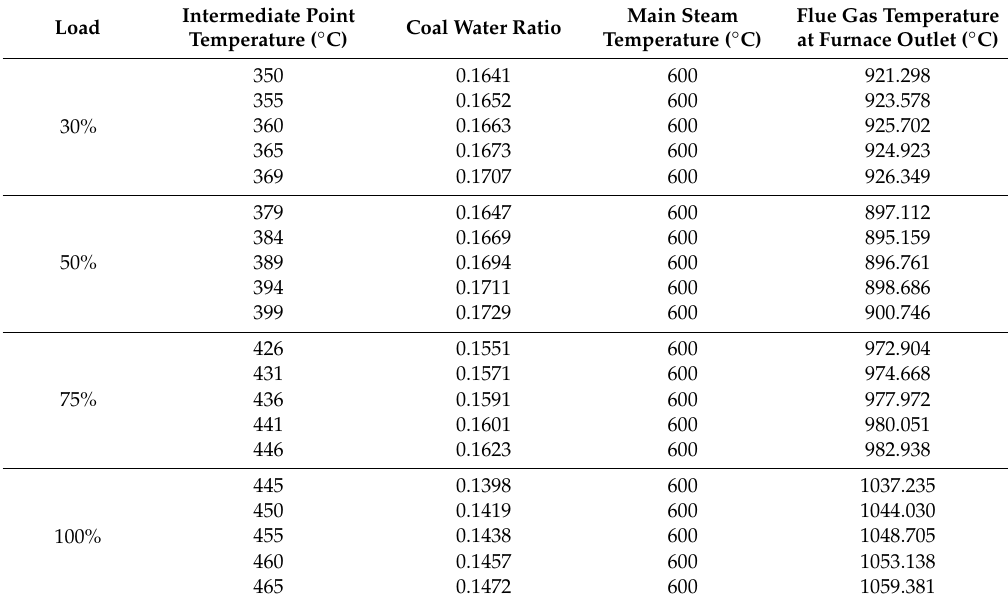
Table 5. Parameters of reference system under four